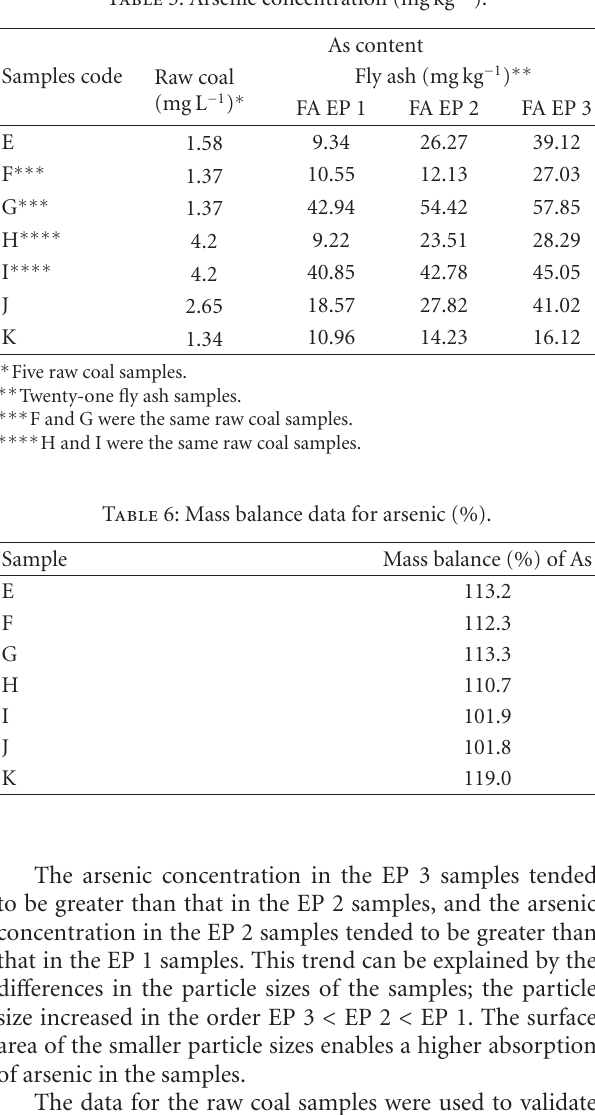
Table 5: Arsenic concentration (mgkg − 1 ).